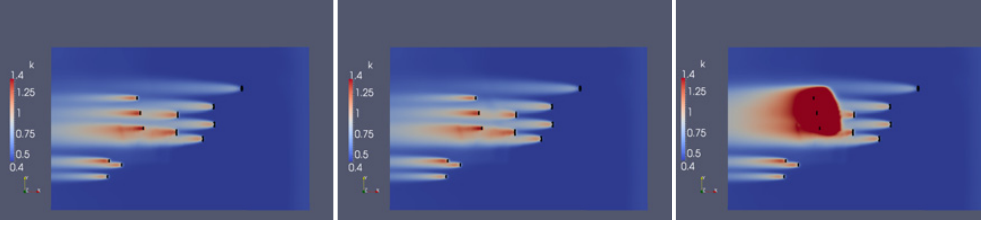
Figure 5. Turbulent kinetic energy (in m 2 s − 2 ) at a height of 65 m for case A (left), B (center) and C (right). Incoming wind from the East direction.